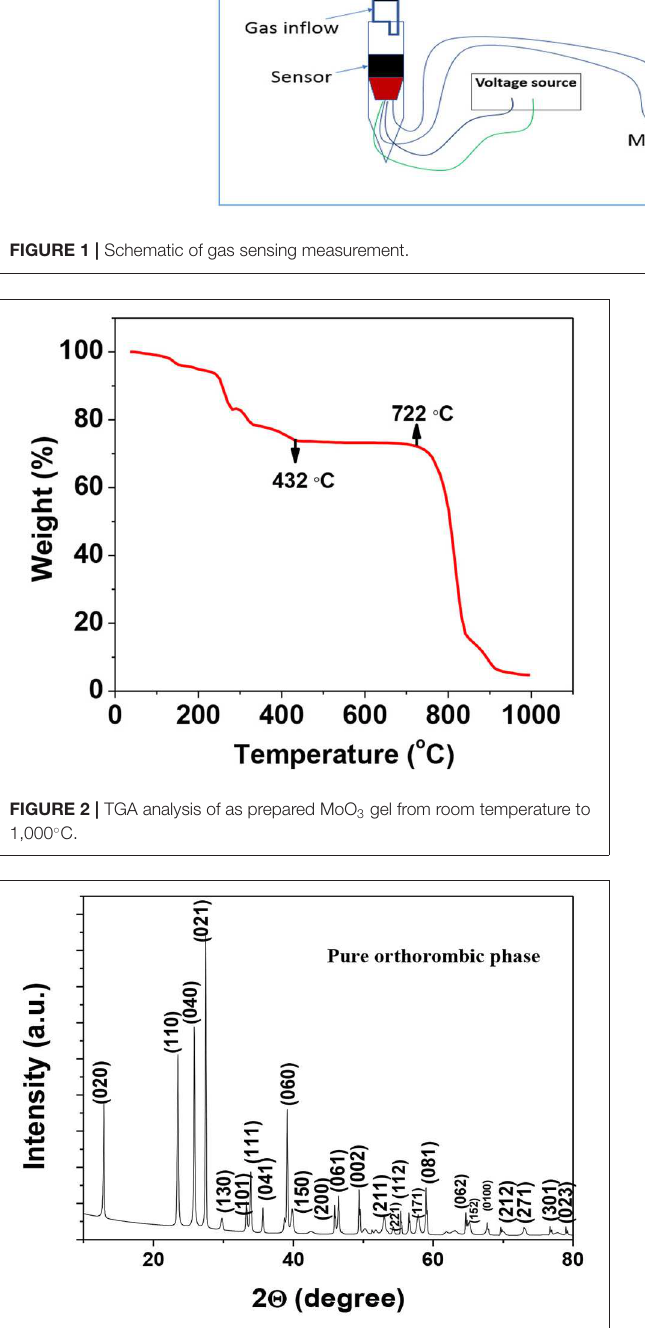
excellent anti-aging properties. Work by Zadeh et al. delineates that Zn doped MoO 3 shows only 20% sensitivity toward 100 ppm of ethanol (Mousavi-Zadeh and Rahman, 2018).